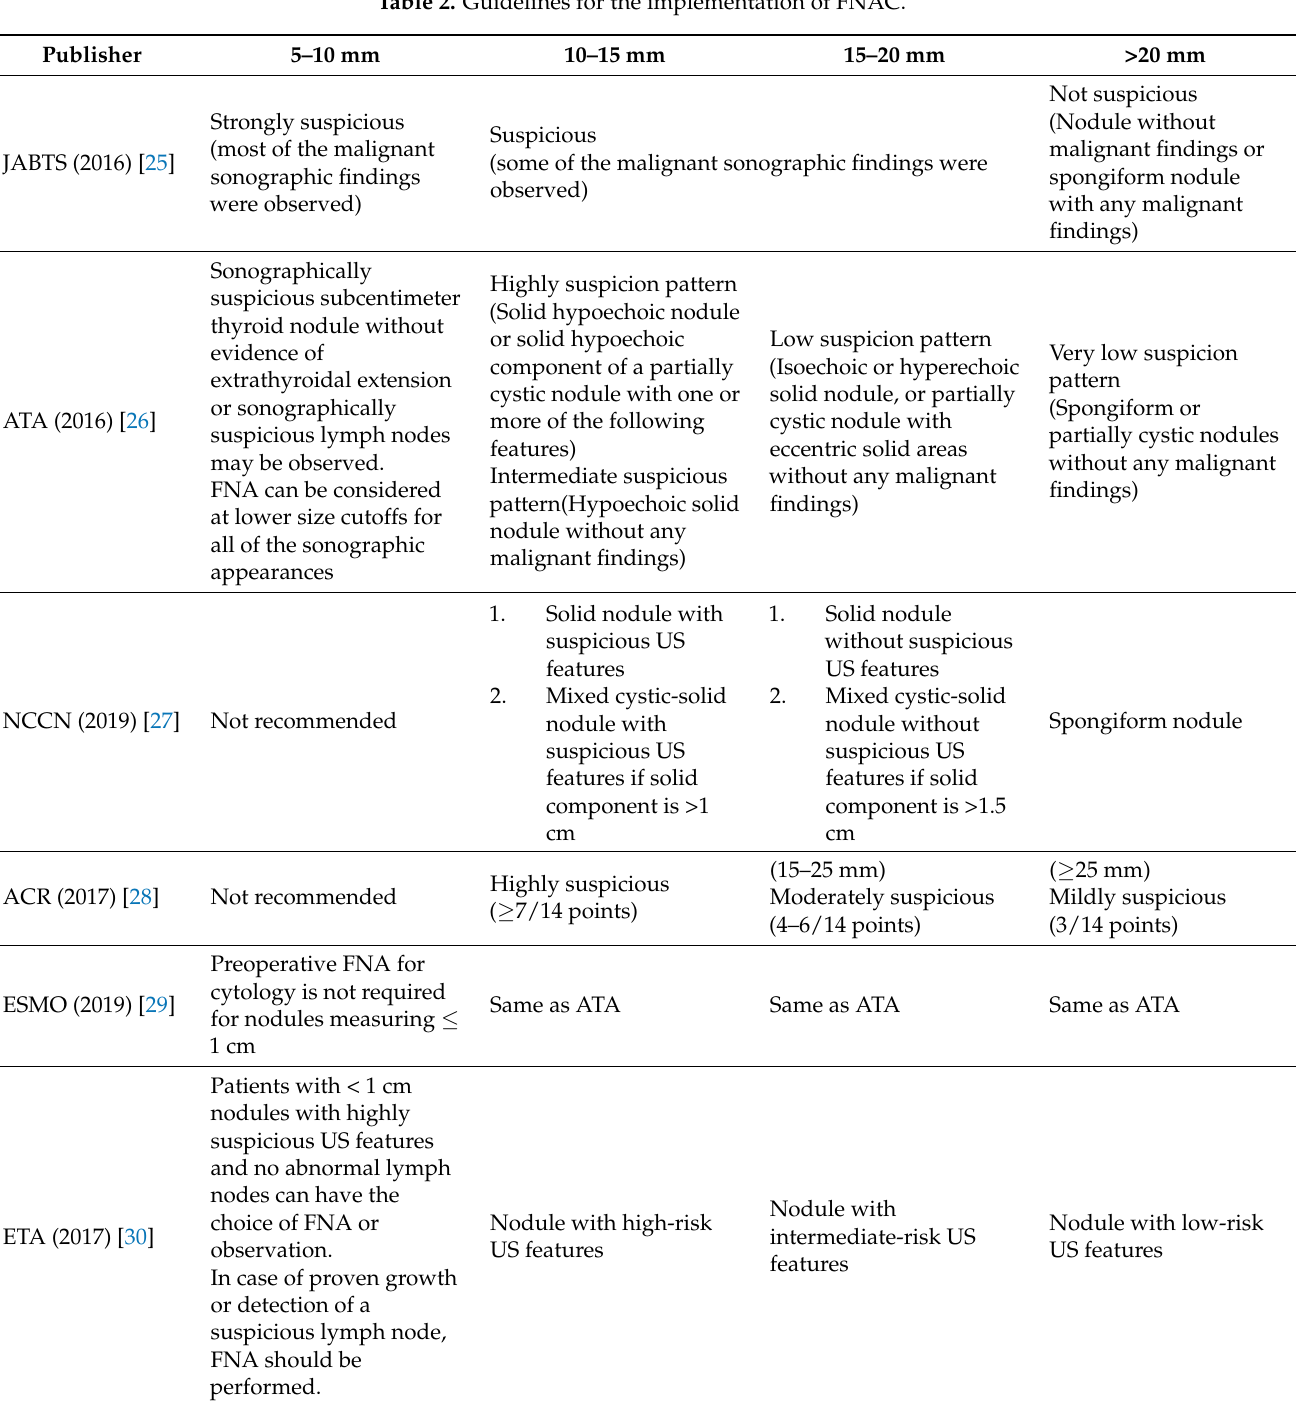
Table 2. Guidelines for the implementation of